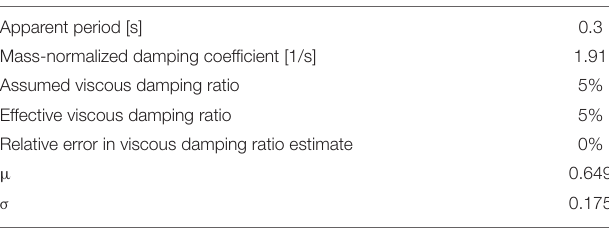
TABLE 1 | Results from analysis of an inelastic frame with no degradation in strength or stiffness that was subjected to harmonic base motion. Apparent period